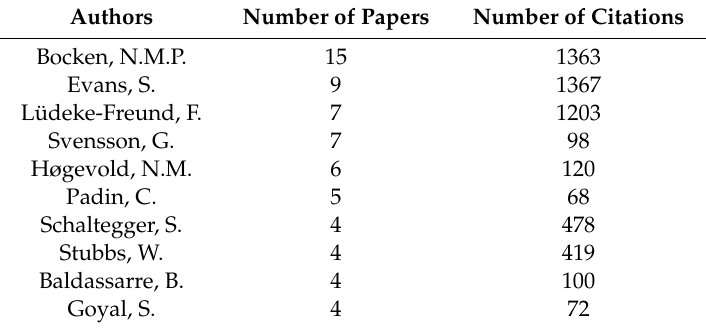
Table 10. Most productive authors in sustainable business models’ research (considering the total number of publications per